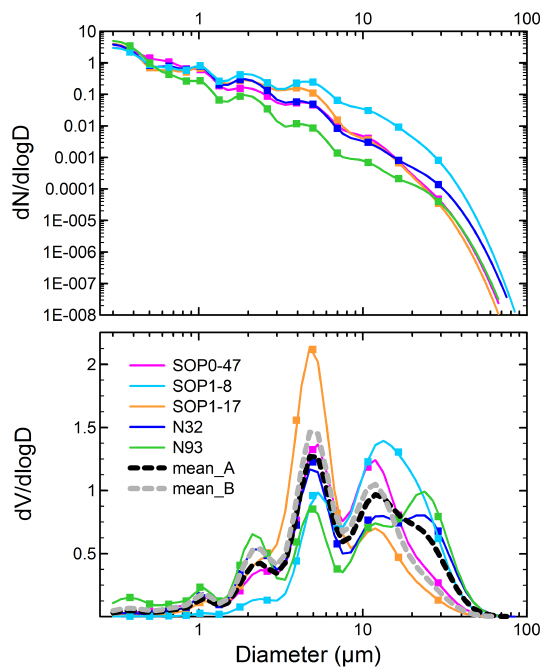
Figure 1. Particle number (d N /dlog D ) and volume (d V /dlog D ) size distributions (normalized with respect to the total number and total volume of particles, respectively) obtained for the five selected dust events. The dots indicate the GRIMM measured values, while the lines are the multimodal lognormal fit data. Black and grey dashed lines are the averages of the volume size distributions for the five samples obtained including (mean_A, black dashed line) and excluding (mean_B, grey dashed line) the largest mode at ∼ 25µm for N32 and N93 samples. The legend in the bottom panel identifies the line styles used in the